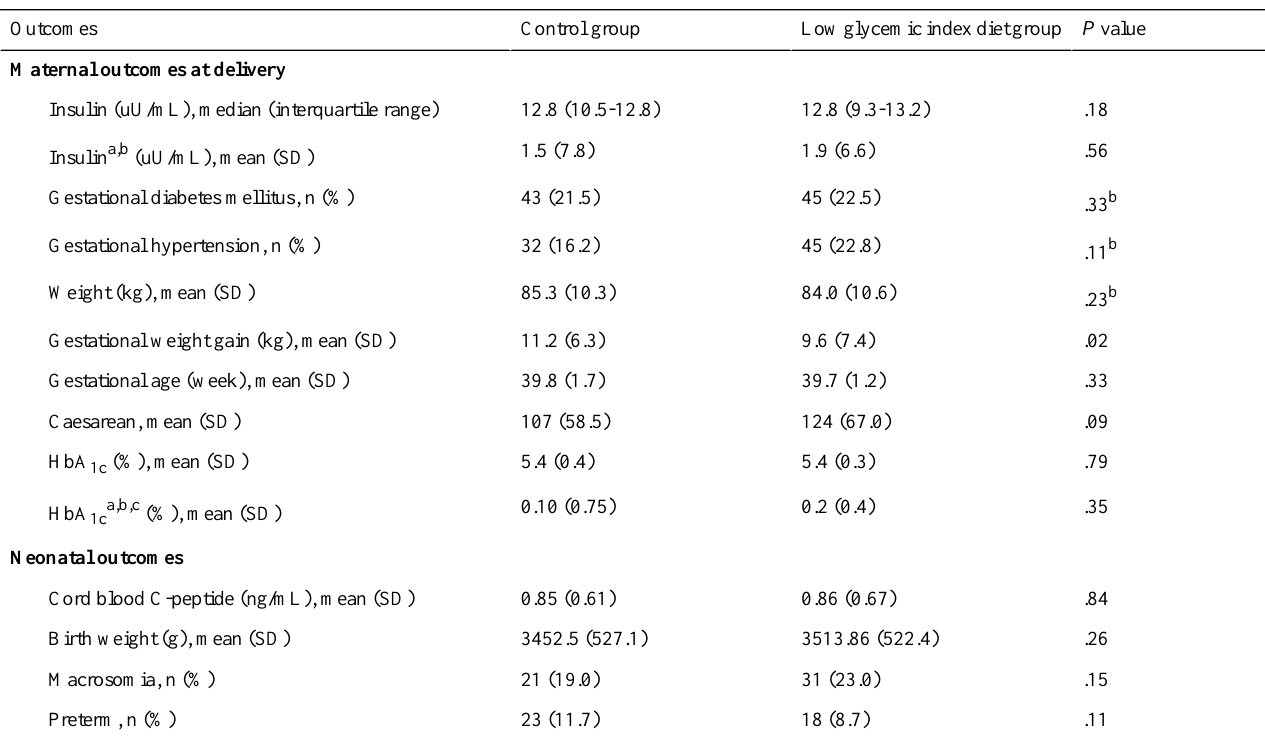
P valueLow glycemic index diet groupControl groupOutcomes